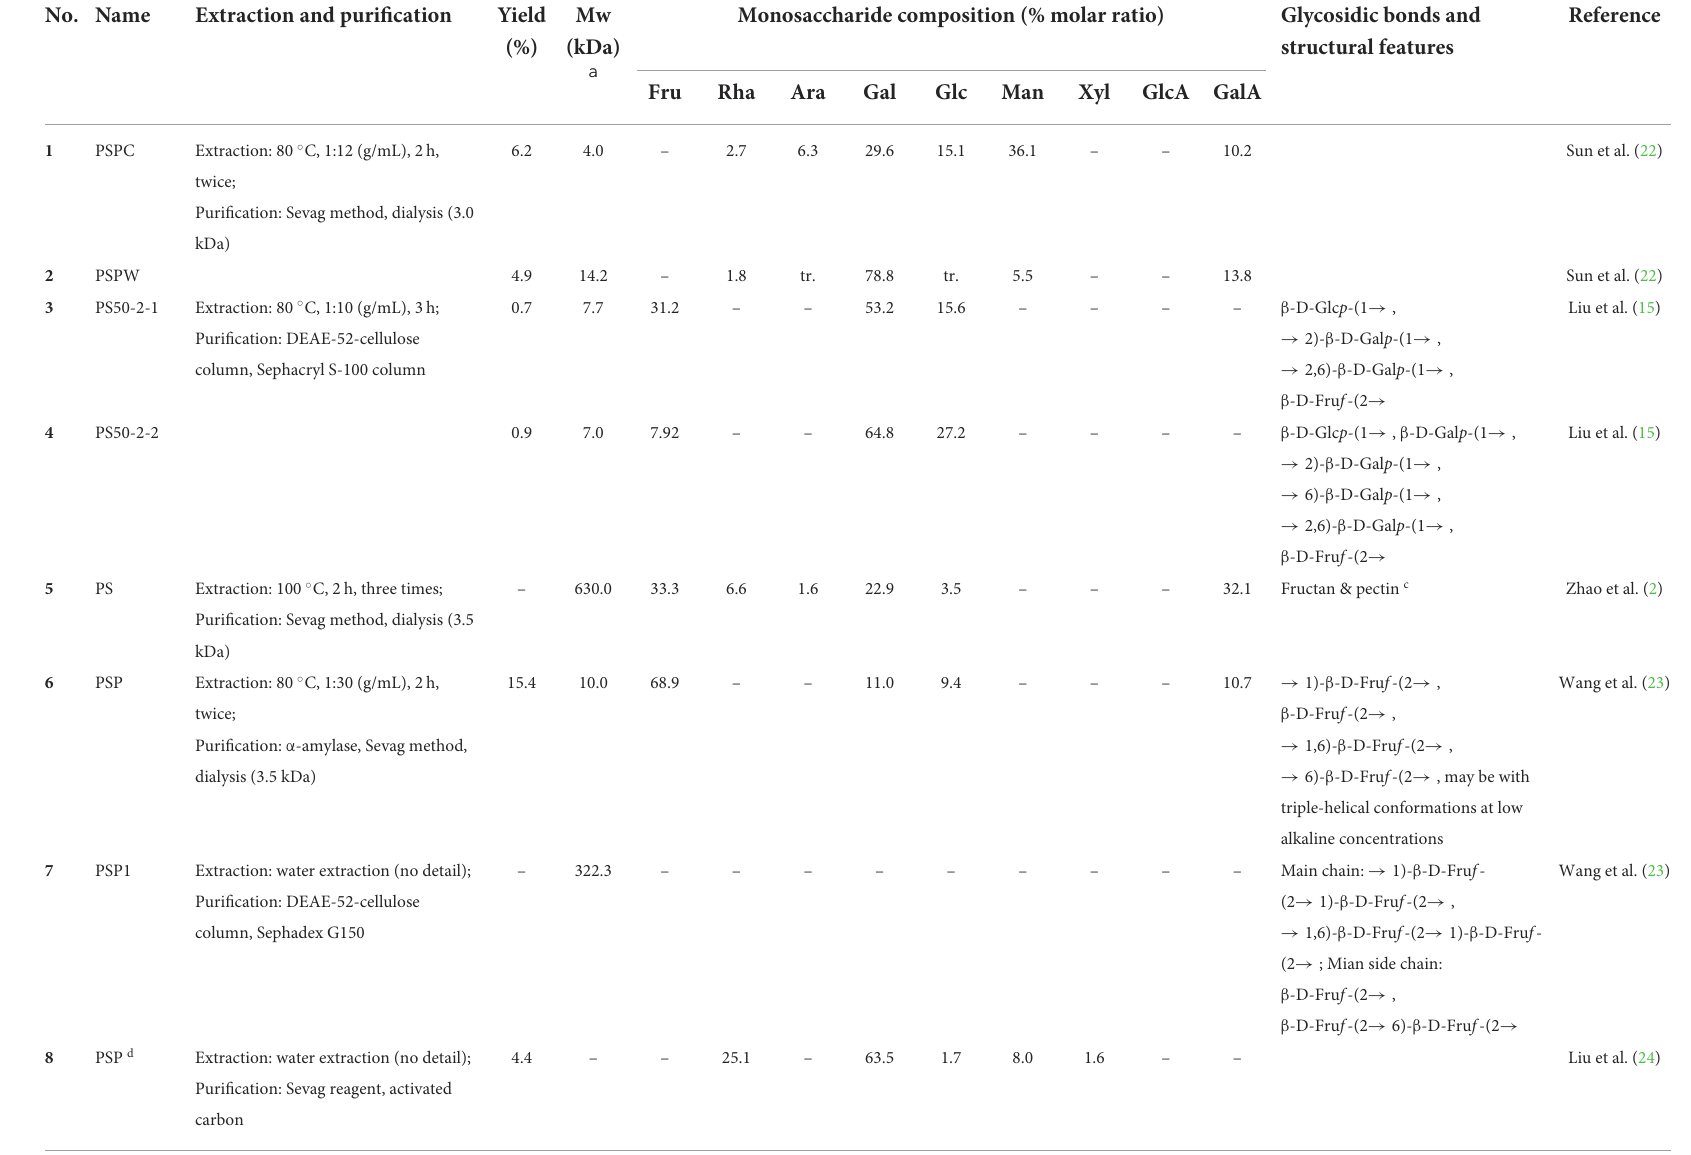
TABLE 1 Chemical composition of Polygonatum sibiricum polysaccharide. No.